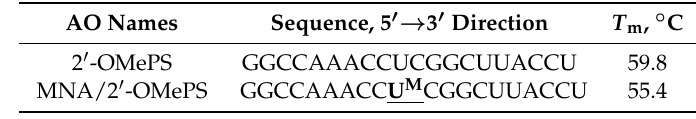
Table 1. Antisense oligonucleotide sequences used in this study.